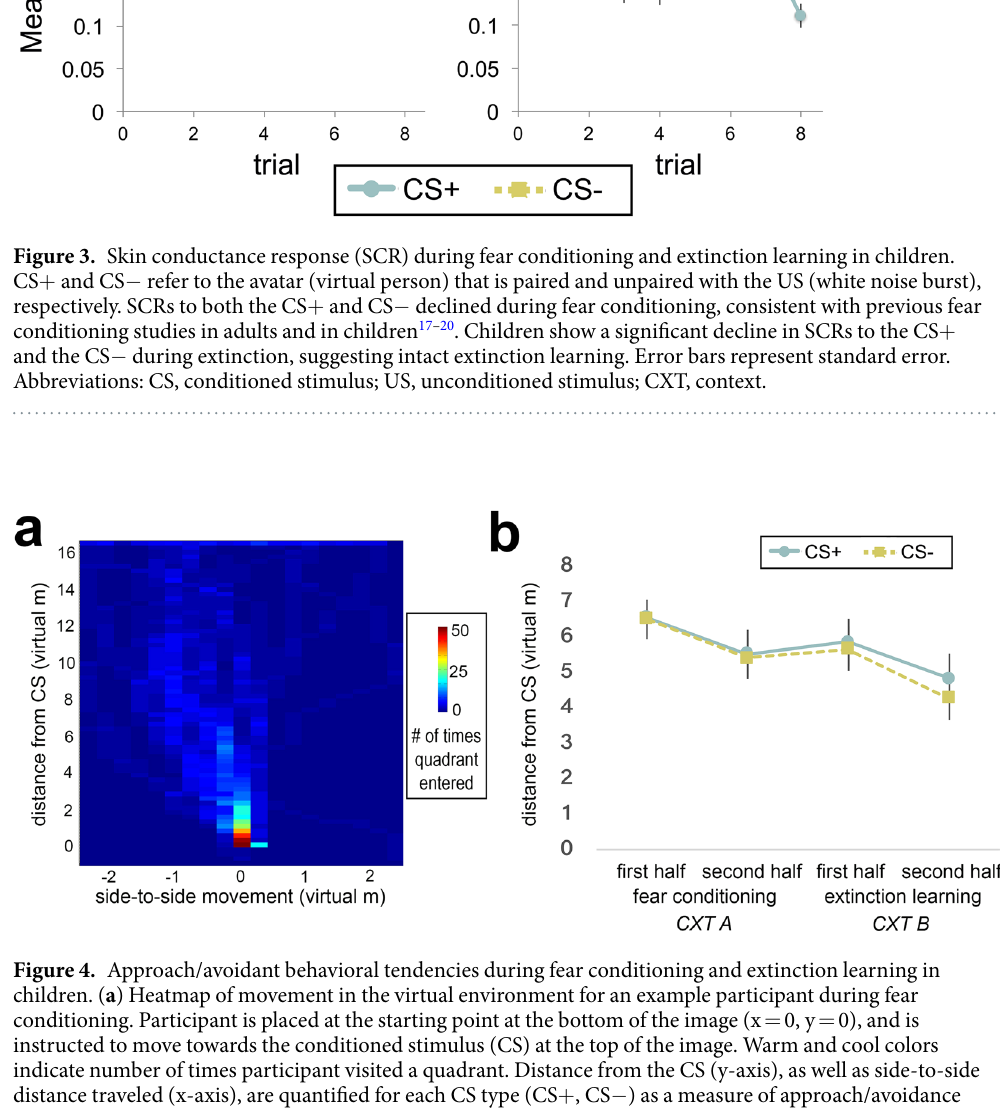
lower SCRs to the last CS − trial during fear conditioning, ( r (40) = − 0.38, p = 0.017), suggesting better differential conditioning in older youth. There were no other effects of age on subjective, physiological, or approach/avoid- ance behavioral measures to the CS + or the CS − during either session.